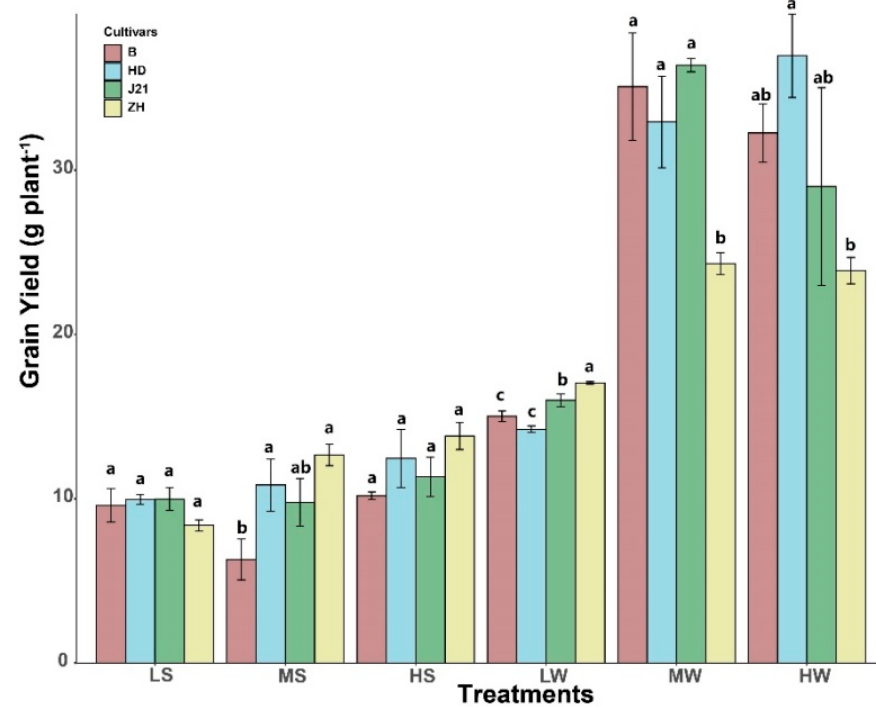
Figure 1. Yield performance of four soybean genotypes [B (Bailudou), HD (Huangsedadou), J21 (Jindou 21), and ZH (Zhonghuang)] under two water treatments [S (cycle water stress), W (well- watered)] and three P levels [L, low P supply (P0), M, mid P supply (P60), H, high P supply (P120)]. The letters under each group of bars indicate different combinations of P and water treatment, with the first letter indicating P level and the second letter representing water treatments. Values are means plus one standard error of the mean ( n = 3). Table 1. Significance of 11 traits (see Figures 1–5) of four soybean genotypes under two water treatments (cycle water stress and well-watered) and 3 P levels (low P supply, mid P supply, high P supply). * p < 0.05; ** p < 0.01; *** p < 0.001; blank cells indicate no significance. Shoot GY DW Genotypes (G) * ** *** PC1 and PC2 captured 64% and 22.7% of the total variation in 11 traits for the four genotypes under WS, and 65.8% and 23.2% of total variation under WW, respectively (Figure 5). PC1 mainly represented resource acquisition, while PC2 mainly represented resource use efficiency. GY was mainly correlated with PC2 under WS (Figure 5A): GY re- lated to HI (r = 0.37, p < 0.05) but not Shoot DW ( p > 0.05), and other resource use efficiency related traits (WUE: r = 0.61; NUE: r = 0.64), with a weaker but significant relationship with resource accumulation related traits (TP: r = 0.48; TN: r = 0.46) (Figure S1A). While under WW and GY mainly determined by PC1 (Figure 5B): GY was determined by shoot DW (r = 0.82, p < 0.001) rather than HI ( p > 0.05), with yield variations mainly associated with resource acquisition traits (WU, TP, TN, GY, root DW, and nodule DW). GY negatively correlated with PUE (r = − 0.52, p < 0.01) and had no relationship with NUE and WUE ( p > 0.05) under WW conditions (Figure S1B). A significant negative correlation